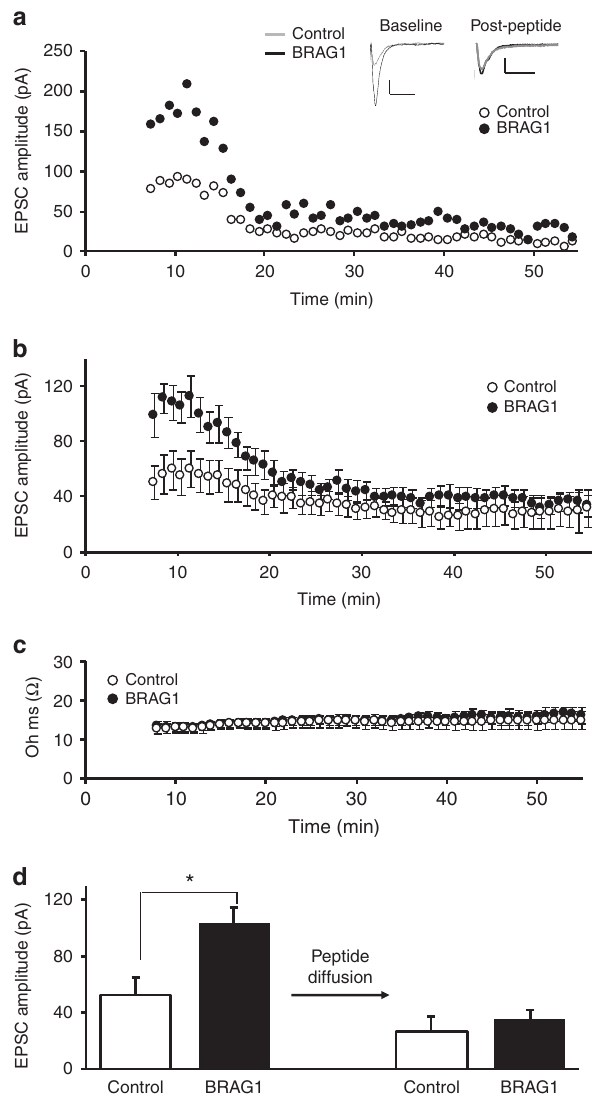
Figure 5 | BRAG1 increases the synaptic pool of AMPA receptors that constitutively recycle. ( a ) Graph of representative time-course experiment of whole-cell double patch-clamp recordings from a control neuron and a neuron transfected with BRAG1. In these experiments, patch pipettes contain 10 m M pep2m in the internal solution. Insets: traces of AMPAR-mediated responses of the representative experiment at baseline (thin line, left) and at the new steady state following pep2m infusion (thick line, right). Scale bars, 20pA, 20ms. ( b ) Averaged EPSC values from adjacent transfected and control cells. Time zero indicates the time at which neurons were patch clamped at (cid:2) 60mV. Note that immediately following patch clamping, BRAG1-transfected neurons have higher AMPAR-mediated responses. Pep2m caused rundown in BRAG1-transfected neurons to a higher degree than in control ones. ( c ) Series resistance values corresponding to EPSC values over time (control versus BRAG1, 0–55min, (up to 12min, n ¼ 8, P o 0.05) and steady state following peptide